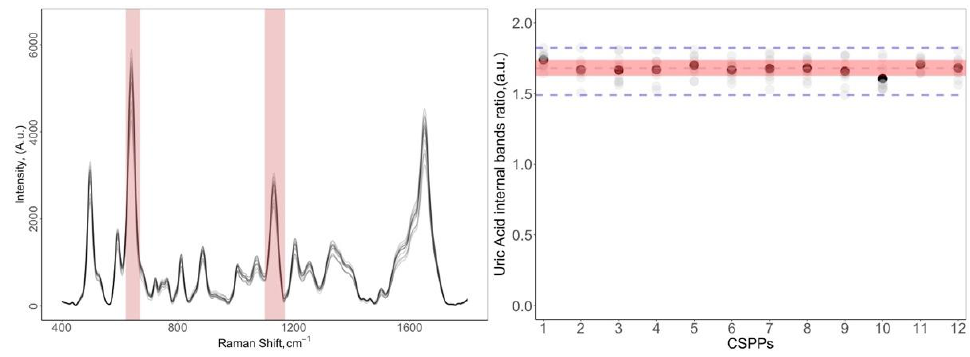
Figure 5. Reproducibility of the CSPP method. ( a ) SERS spectra of 12 different CSPPs; ( b ) Distribution of the ratio between the 640 (skeletal ring deformation) and 1132 (C-N) cm −1 bands of uric acid over the 12 CSPPs. Black dots correspond to the mean value of 10 randomly chosen positions on the same CSPP. The limits of the shaded area are the upper and lower quartiles, calculated over the entire set of measurements, so the area spans the interquartile range (IQR), corresponding to the range covered by 50% of the data. The dashed lines mark the median and the extremes of the acceptance area (1.5 x IQR).